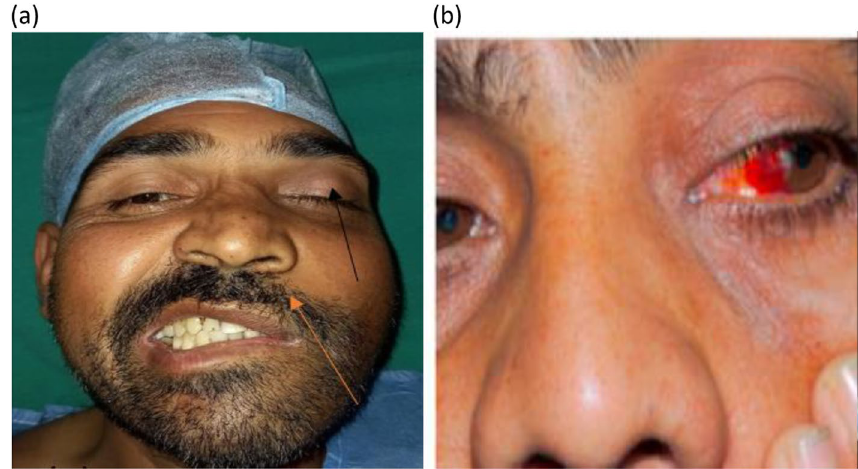
Fig. 4 a , b Images of illustrative case from case series 3. a (L) LMN type House Brackmann Gd V facial palsy with complete ophthalmoplegia (L) and ptosis (L). b Red eye (L) with diminution of vision in a case of rhinosinusitis with intracranial and intraorbital